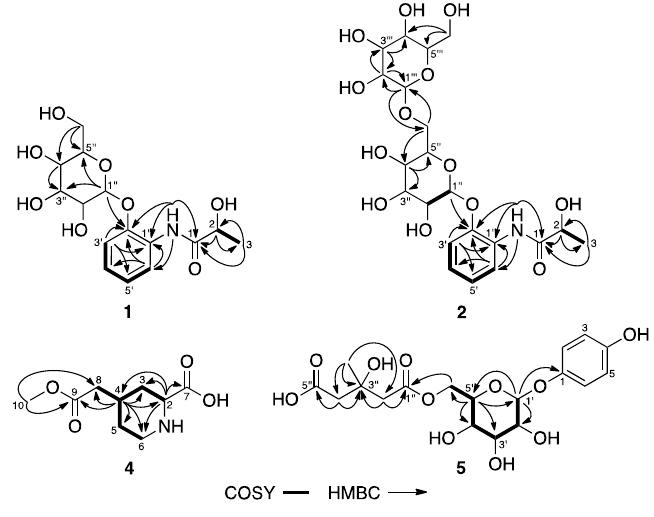
Figure 2. Selected 1 H- 1 H COSY and HMBC correlations of 1 , 2 , 4 , and 5 . Table 1. 1 H- (500 MHz) and 13 C-NMR (125 MHz) data of 1 and 2 in DMSO- d 6 .